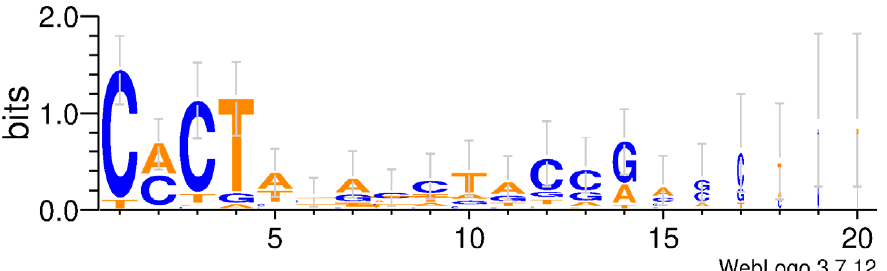
Figure 3. The logo figure of piggyBac ( PB ) Transposons’ TIR ( n = 40). The online website Welogo v.3.7.12 (http://weblogo.threeplusone.com/create.cgi, accessed on 16 December 2022) was used to create logo images of the TIR sequences. The value 2 on the y axis stands for maximum possible frequency.